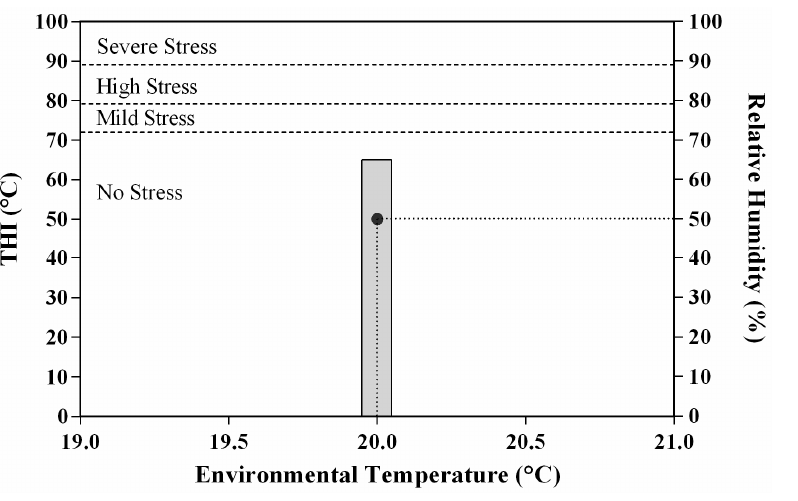
Figure 1. Mean values of ambient temperature, relative humidity and temperature–humidity index (THI) recorded on the day of official races. Table 1. Schedules of training program performed by horses belonging to Group 1 (1200 m/race; n = 10), Group 2 (1600 m/race; n = 10) and Group 3 (2000 m/race; n = 10).